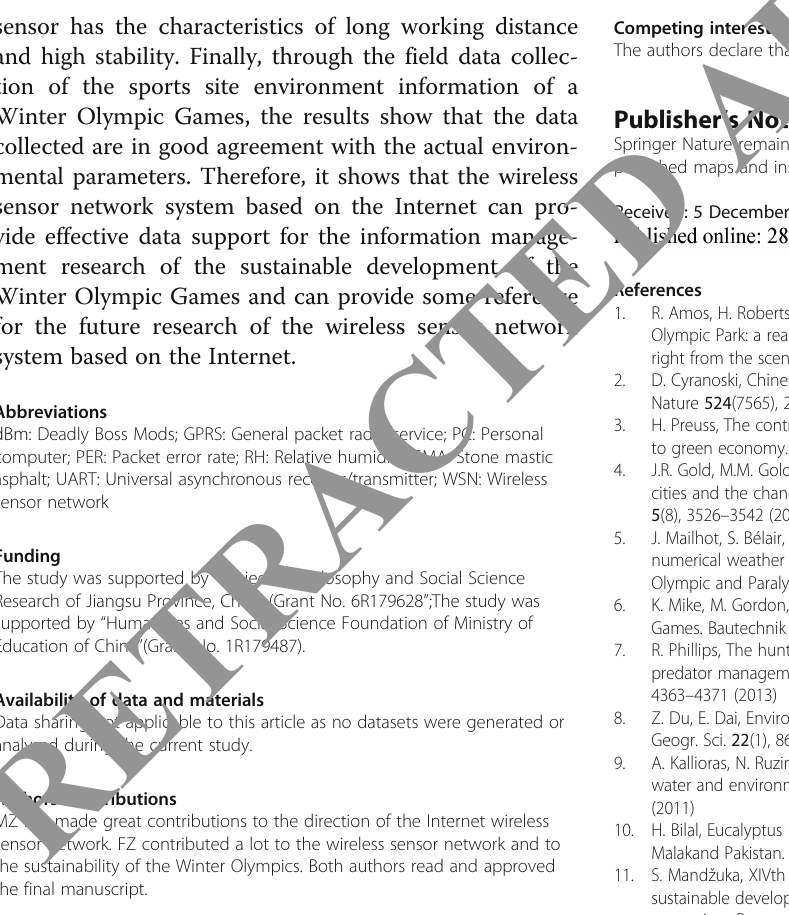
Fig. 8 The data curve of environmental carbon dioxide concentration collected by the